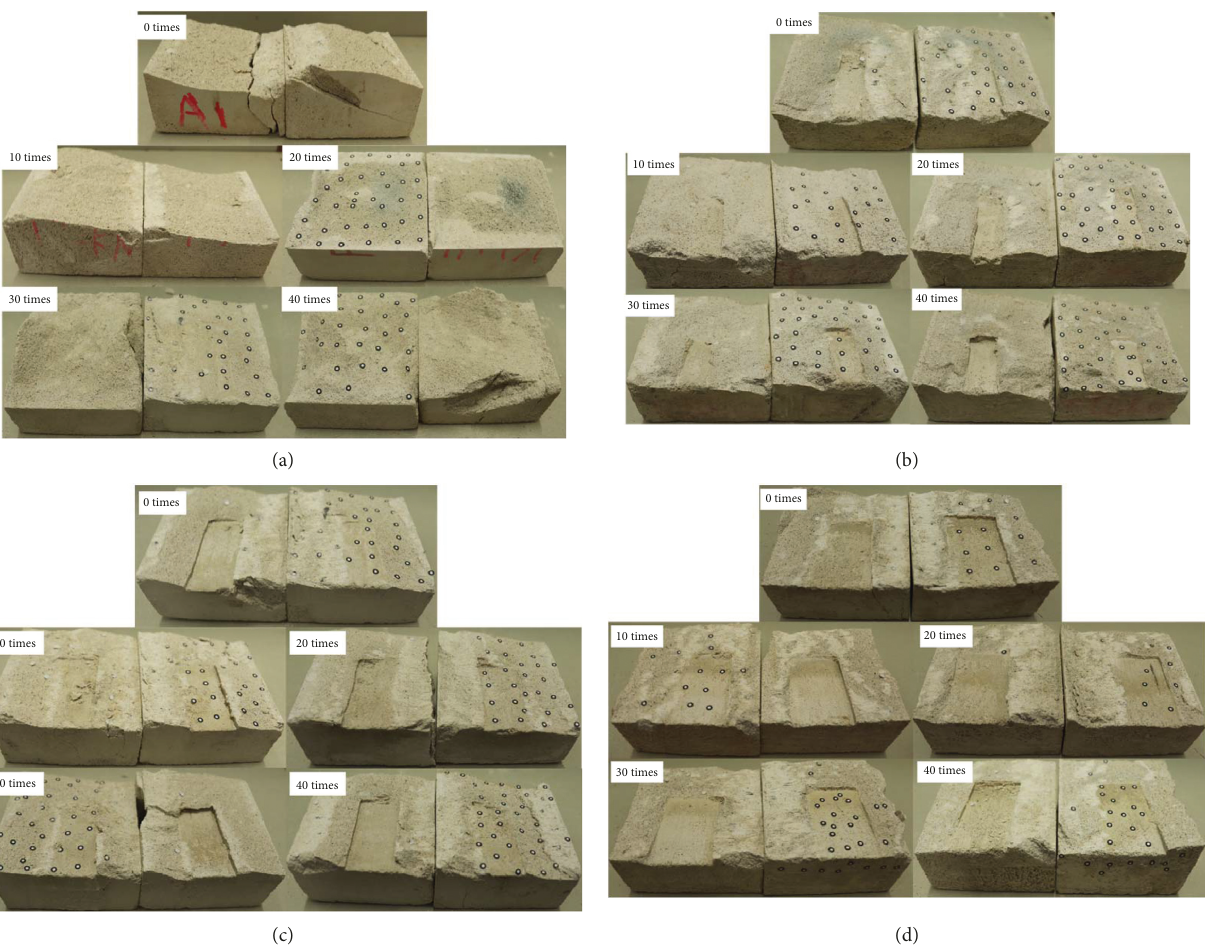
Figure 6: The shear specimens after different freezing-thawing cycles. (a) λ � 0% shear specimen after freezing-thawing cycles, (b) λ � 20% shear specimen after freezing-thawing cycles, (c) λ � 30% shear specimen after freezing-thawing cycles, and (d) λ � 40% shear specimen after freezing-thawing